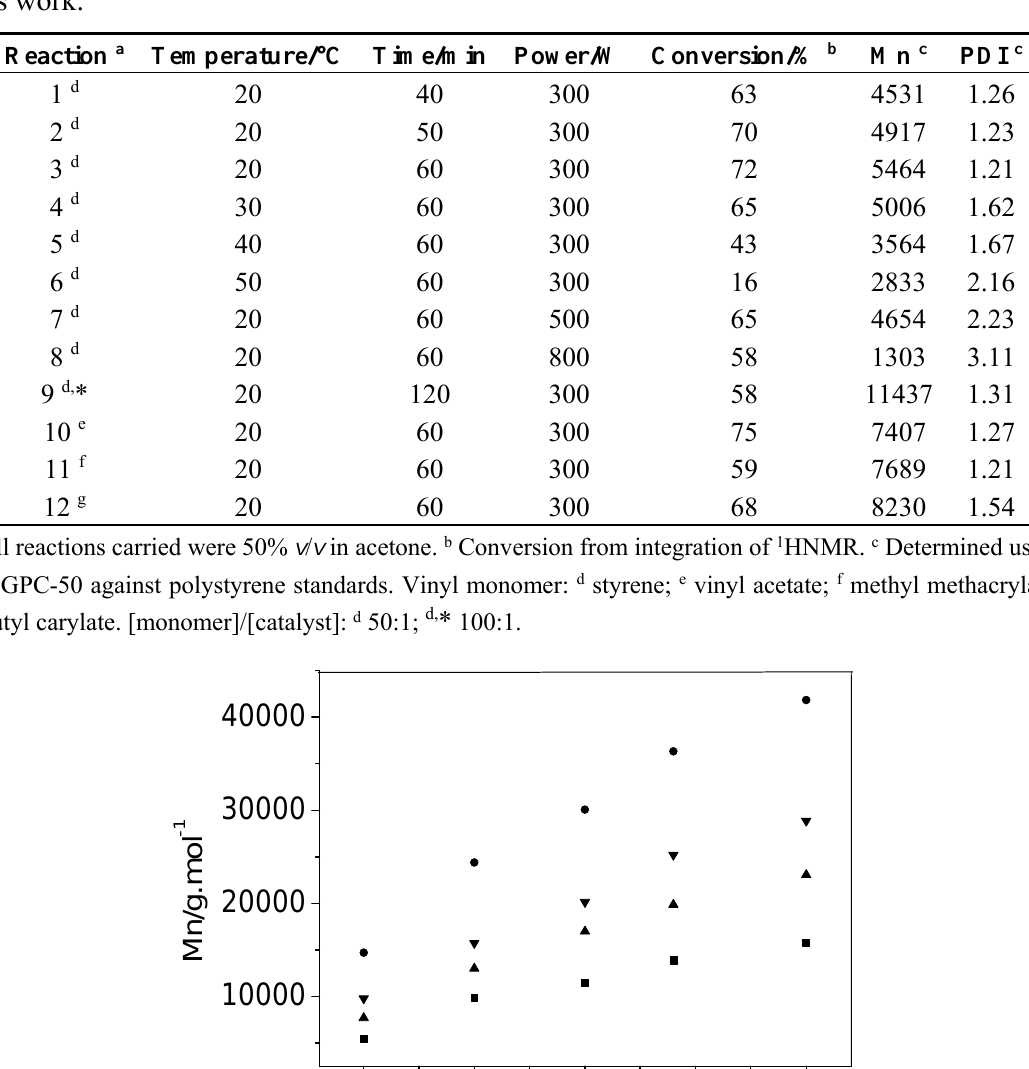
Table 1. Final molecular weight and conversion data for the polymers synthesized in this work.